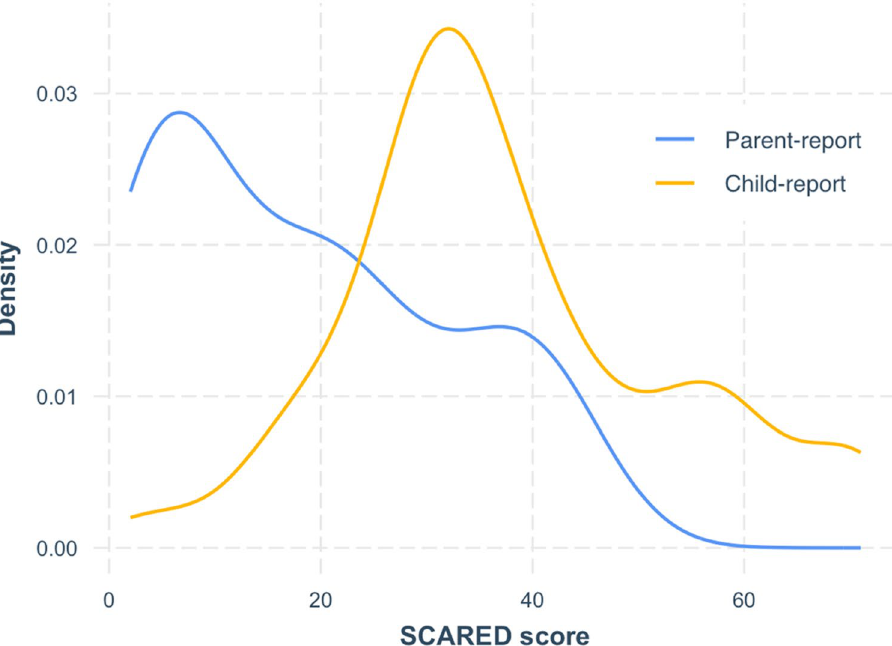
Figure 1. Density distribution of parent- and child-reported scores on the Screen for Child Anxiety Related Disorders (SCARED). Shapiro–Wilk statistical testing for normality revealed skewed distribution of the parent- report ( p = 0.002) but not child-report ( p = 0.11). Parent-reported SCARED scores were log-transformed to reduce data